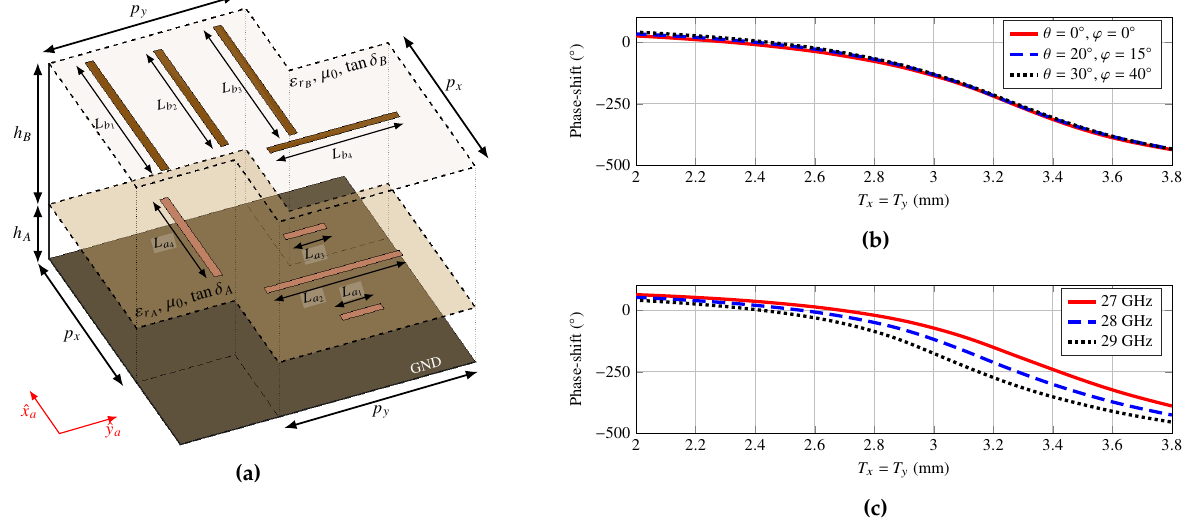
Figure 4. ( a ) Sketch of the employed unit cell, consisting of two layers of parallel and coplanar dipoles, arranged in two sets of parallel dipoles to control both linear polarizations independently. ( b ) Phase response of the unit cell for normal and oblique incidence at 28GHz, showing that the unit cell response is stable with the angle of incidence. ( c ) Phase response of the unit cell for three different frequencies for oblique incidence with ( θ = 40°, ϕ = 30° )